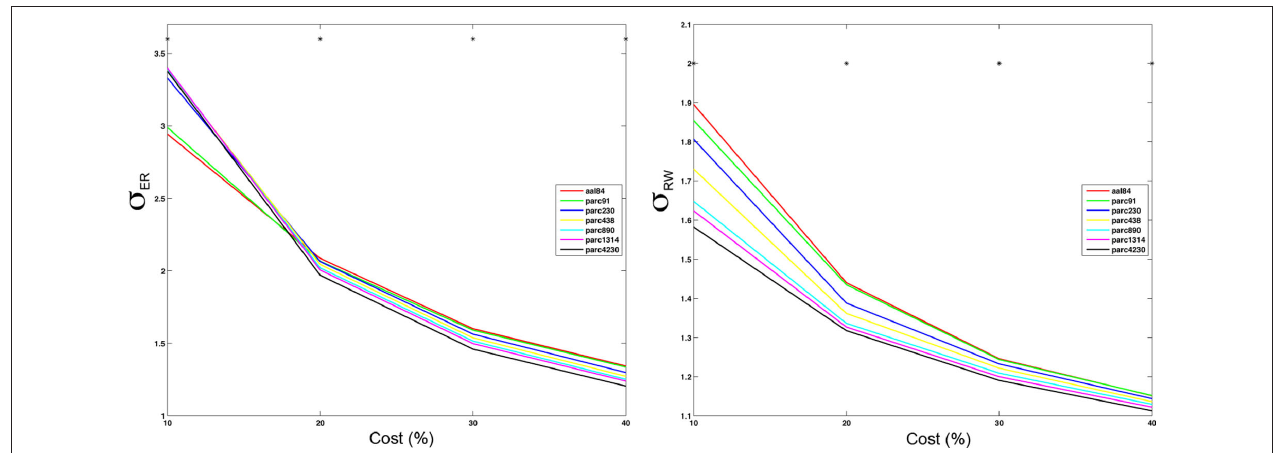
FIguRe 7 | Mean small-worldness ( σ ) values computing using eR- or RW-normalization (left and right respectively) for each parcellation scale at costs of 10, 20, 30, and 40%. * p <